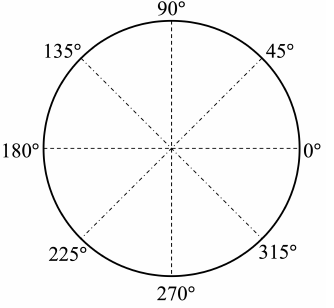
Figure 21. Typical angle of the